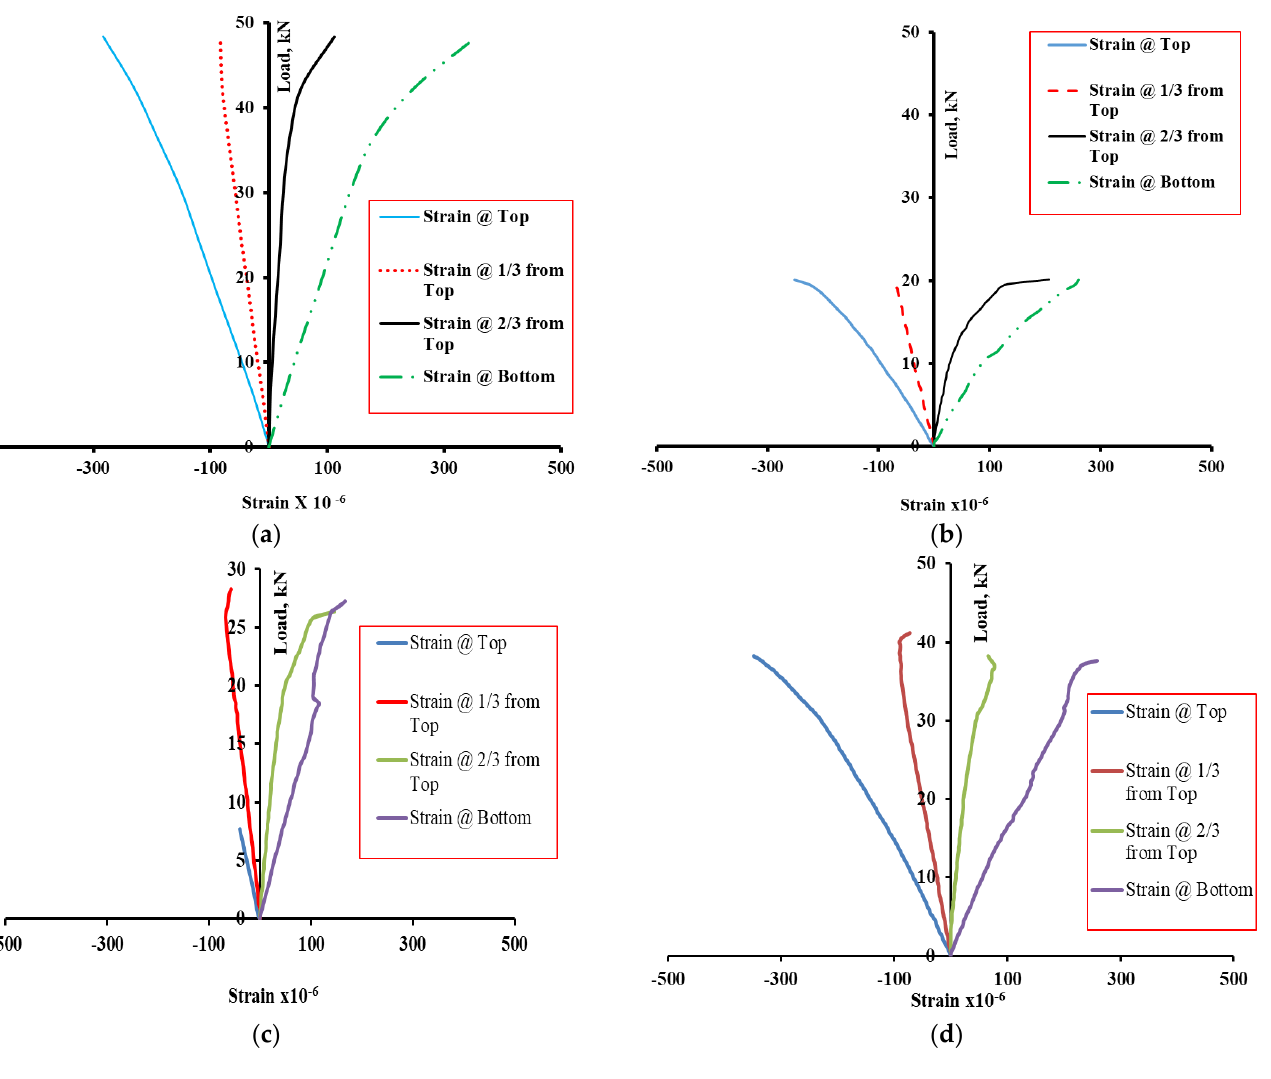
P U at the bottom face. The compressive strain at the top is almost nonlinear except at nearly 95% of P U . Similar observations can be made for the beams D25 and D50 (Figure 10c,d). The load–strain response is almost linear, with the strain at the top face showing slight nonlinearity at higher load. At lower load levels (service load), the strains in the hybrid beam are linear. The linearity of the strain confirms that no slip occurs between the UHPC and the normal concrete and adequate bonding exists between NC and UHPC layers at the interface.